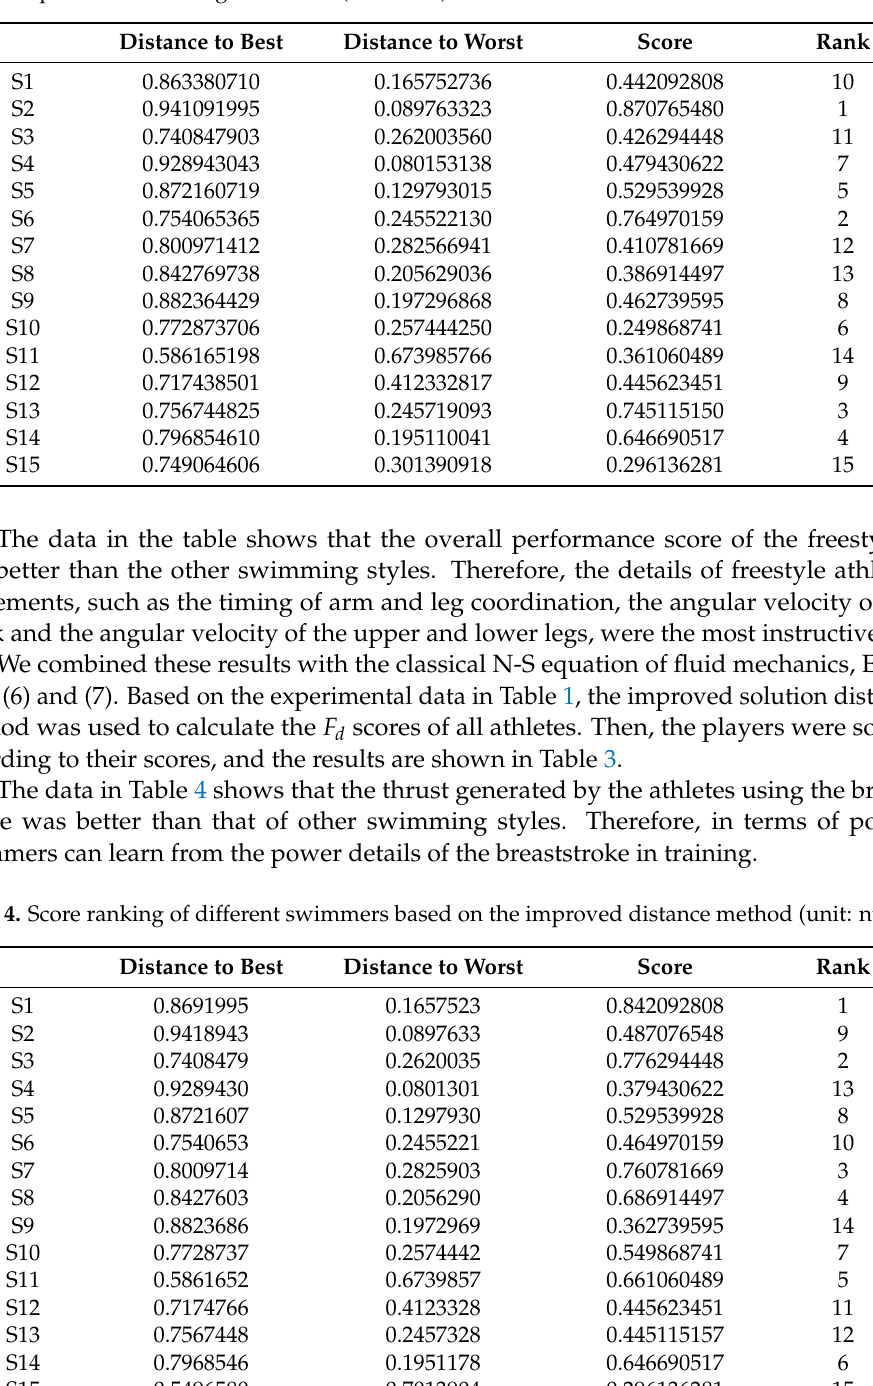
Table 3. Speed score ranking of athletes (unit: null).